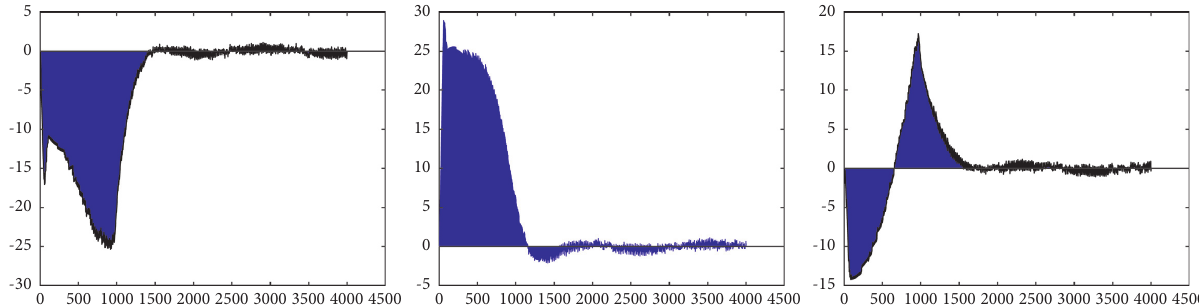
Figure 8: Comparison of predicted